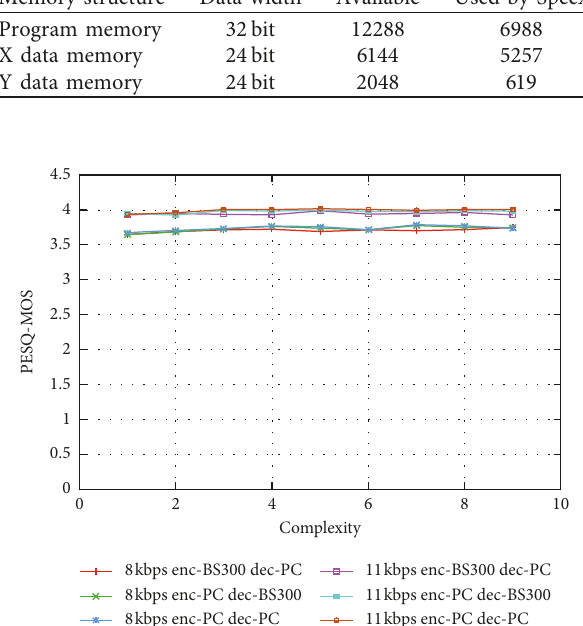
Figure 4: Speech quality of Speex implementation in BelaSigna 300.